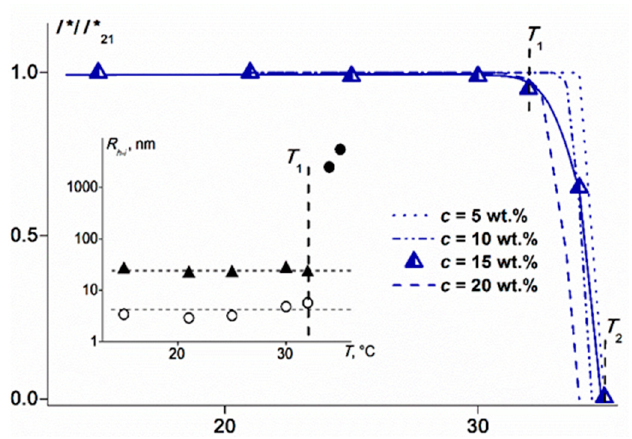
Figure 5. The temperature dependence of the optical transmittance I *, related to its value I * 21 at T = 21 °C, of CL-PiPrOx aqueous solutions. Inset: The temperature dependences of hydrodynamic radii of the fast ( R f , open circles) and the slow ( R s , closed triangles) mode particles and aggregates (closed circles) for 15 wt.% CL-PiPrOx in water.